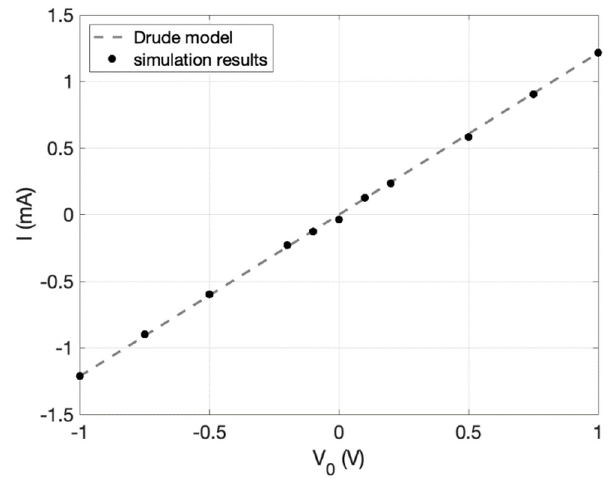
Figure 2. Verification of the simulation algorithm’s current–voltage prediction. The simulator was run for a simple rectangular strip of length 10 μ m and width 2.5 μ m. The carrier density was 7.2 × 10 11 cm -2 , the electron effective mass was 0.02, and λ MFP was 500 nm. The black dots are the simulated current, I , for applied voltage, V 0 . The dashed line is what is predicted analytically from the Drude model for the given parameters.